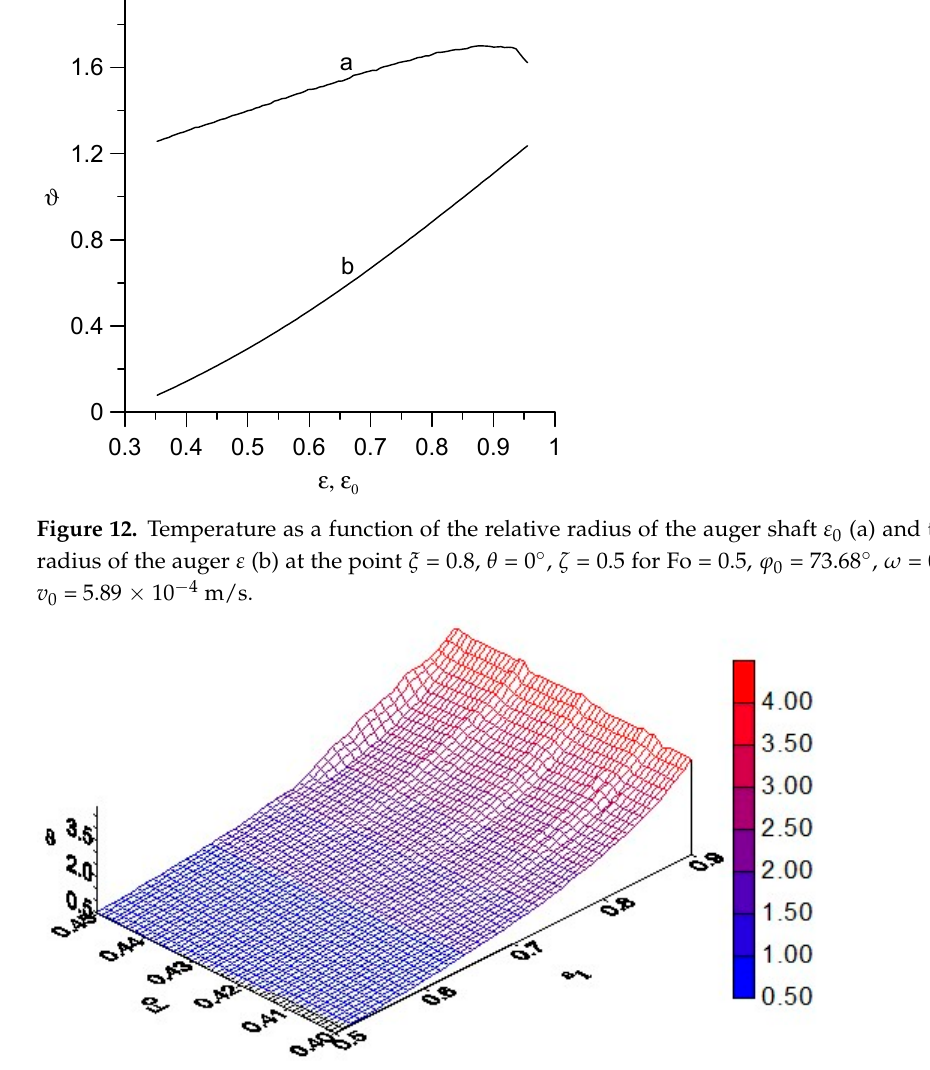
Figure 13. The dependence of temperature on parameter ε 1 at the point ξ = 0.8, θ = 0°, ζ = 0.5 п p и φ 0 = 73.68°, ω = 0.292 Hz, v 0 = 5.89 × 10 − 4 m/s.